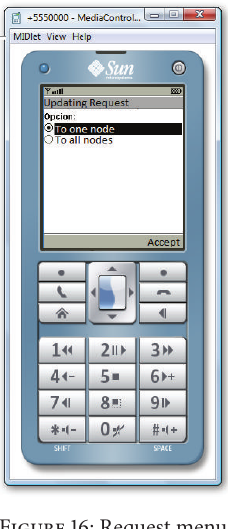
Figure 16: Request menu.